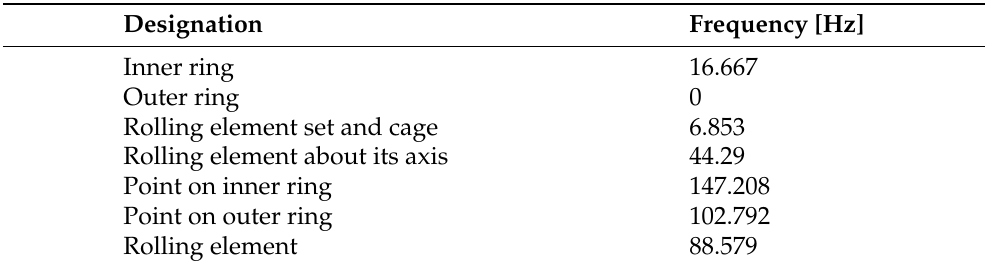
Table 3. Characteristic frequencies for SKF 22324 bearing operating at 1000